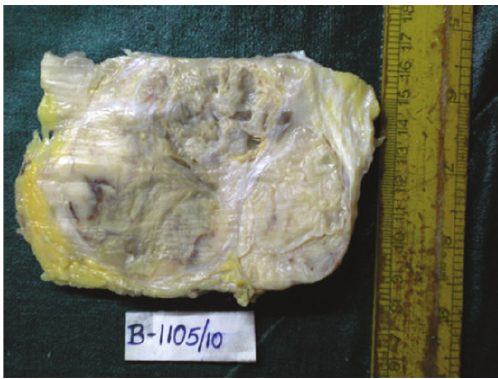
Figure 3: Highly pleomorphic spindly tumor cells with abundant atypical mitoses; (H&E 40x).